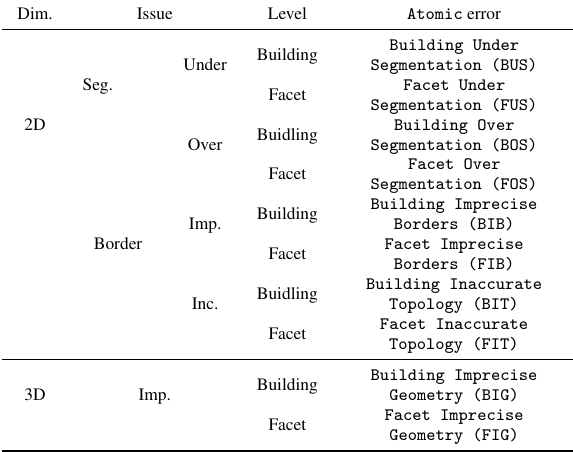
Table 1. Table summarizing all atomic errors. Dim. ( resp. Seg., Imp. and Inc.) stands for dimensionality ( resp. segmentation, imprecision and